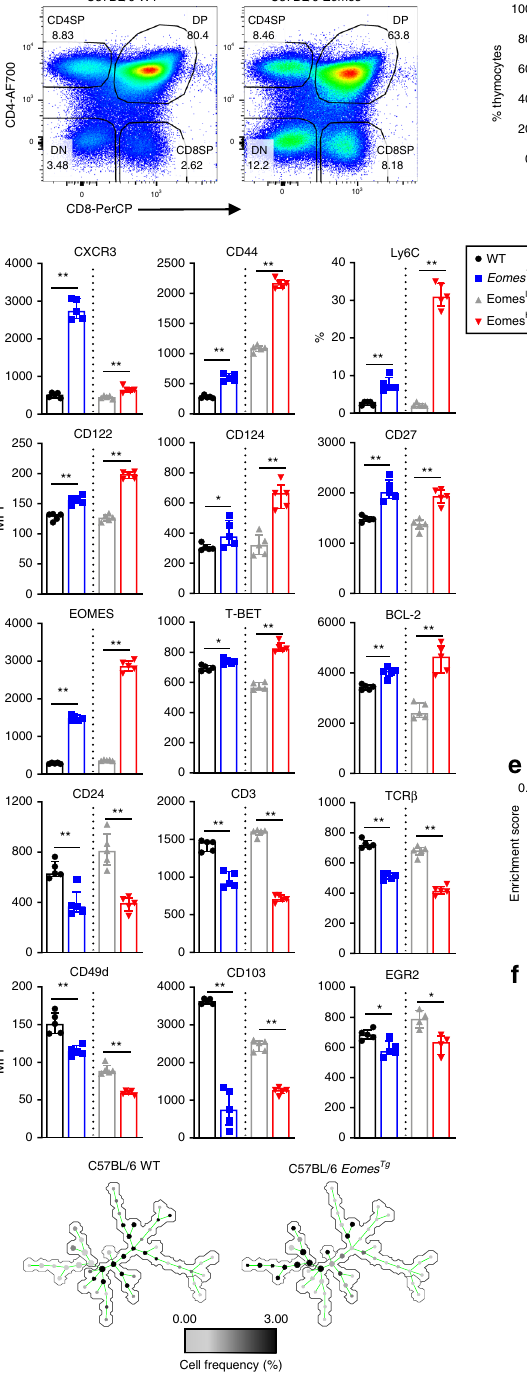
cultured in the presence or absence of rmIL-4 (Peprotech) for 72 h at 20 ngml − 1 before staining, or for 30 min at 30 ngml − 1 before phospho-STAT6 staining. Administration of IL-4 complex in vivo . Carrier-free rmIL-4 (1.5 µg/mouse, Peprotech) was mixed in PBS (200 µl/mouse) with neutralizing anti-mouse IL-4 antibodies (50 µg/mouse, Bio × Cell, clone 11B11, catalog number BE0045). Control mice received only an anti-trinitrophenol Rat IgG1 isotype control (50 µg/mouse, Bio × Cell, clone TNP6A7, catalog number BE0290). Mice were injected daily for 4 days intraperitoneally before harvesting thymi and spleens.